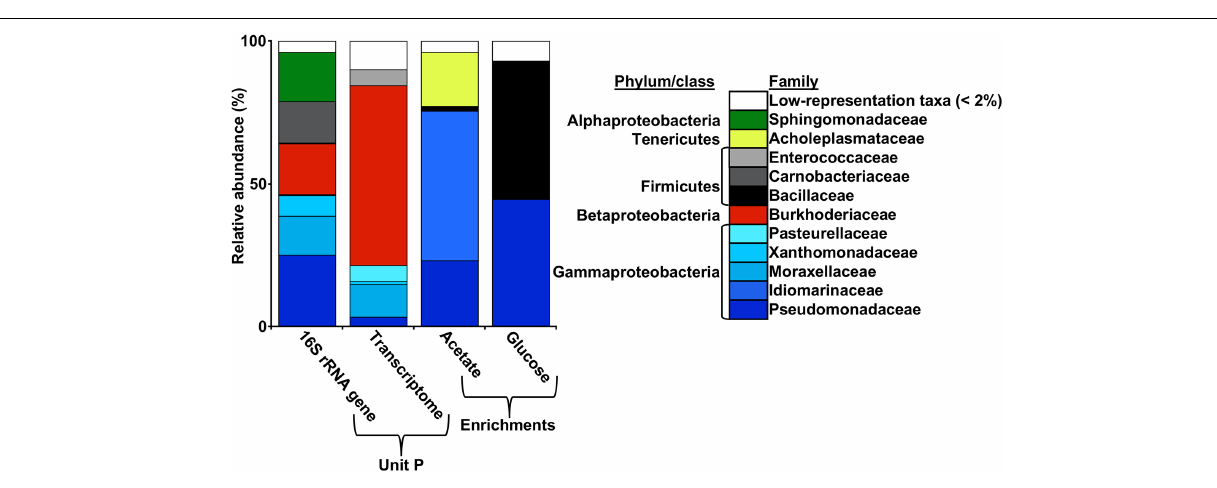
FIGURE 3 | Relative abundances of 16S rRNA gene sequencing-derived OTU at the family level, consensus family level taxonomic assignments of 16S rRNA in the Unit P transcriptome, and 16S rRNA gene sequencing-derived family level taxonomic composition of aerobic acetate- and glucose-oxidizing enrichment cultures from Unit